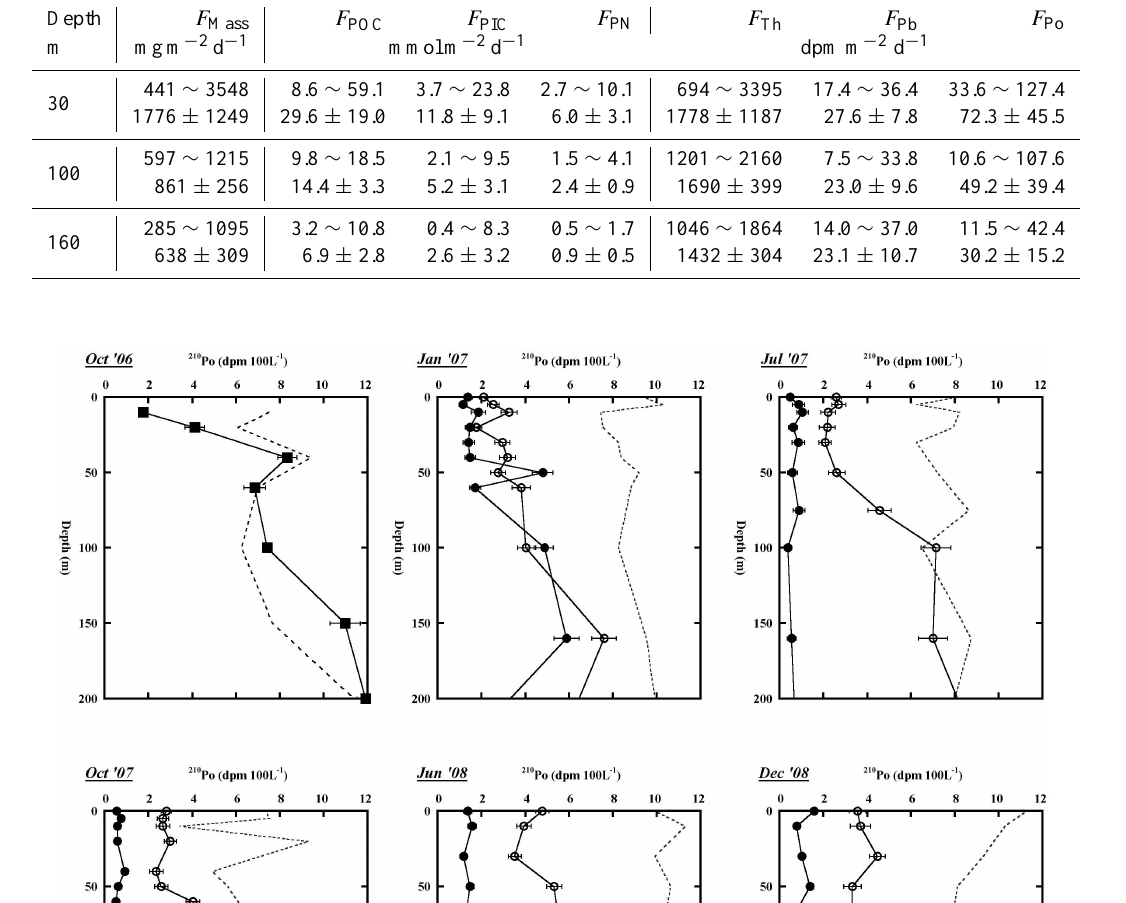
Table 1. Range, average, and standard deviation of sinking fluxes of total mass ( F Mass ), POC ( F POC ), PIC ( F PIC ), PN ( F PN ), 234 Th ( F Th ), 210 Pb ( F 210 Po ( F Po ) at three depths during October 2006 and December 2008. Pb ), and